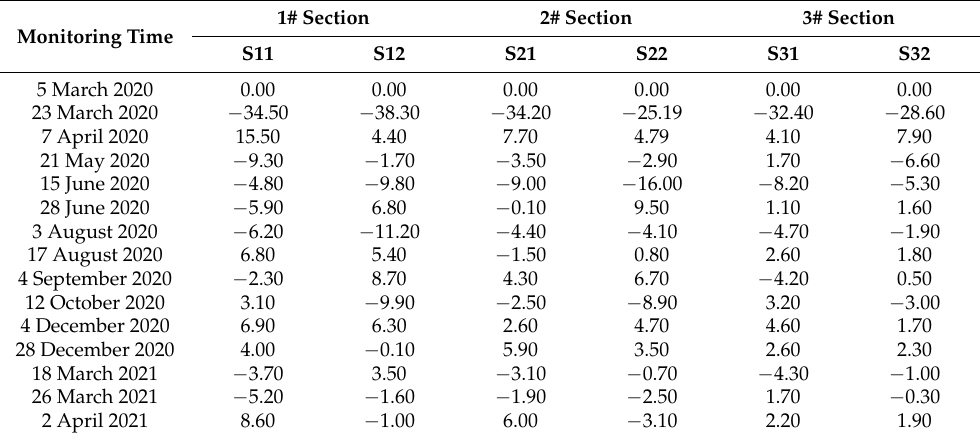
Figure 12. 3 # section settlement displacement duration curve (downward is +, upward is − ). Table 3. Settlement.